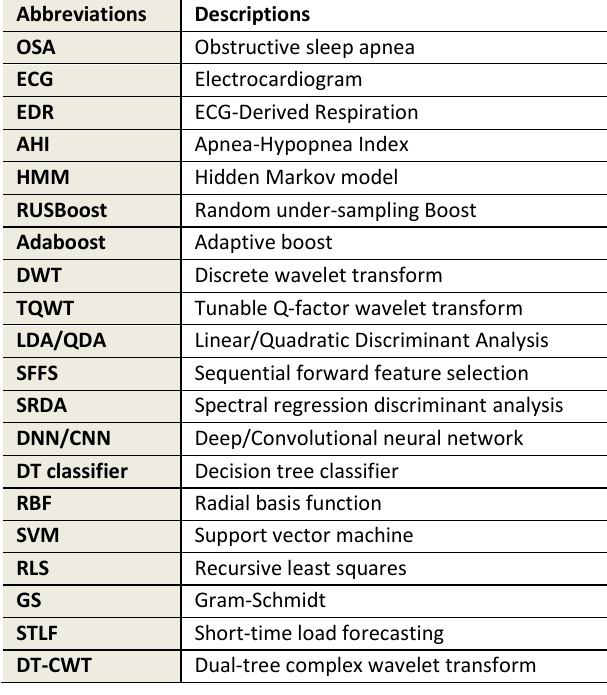
Table 1. List of the used